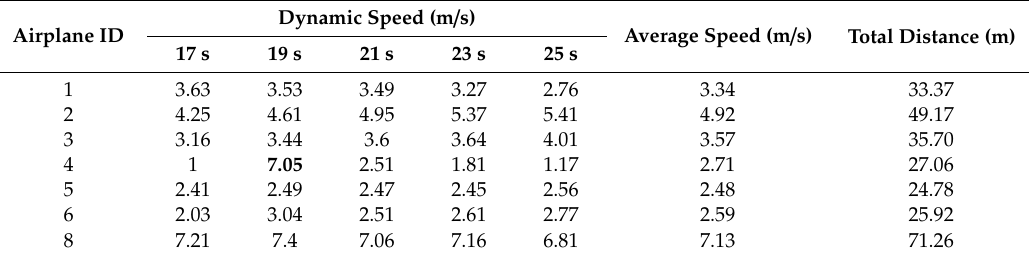
Table 3. Movement properties of Airplane 1–6 and